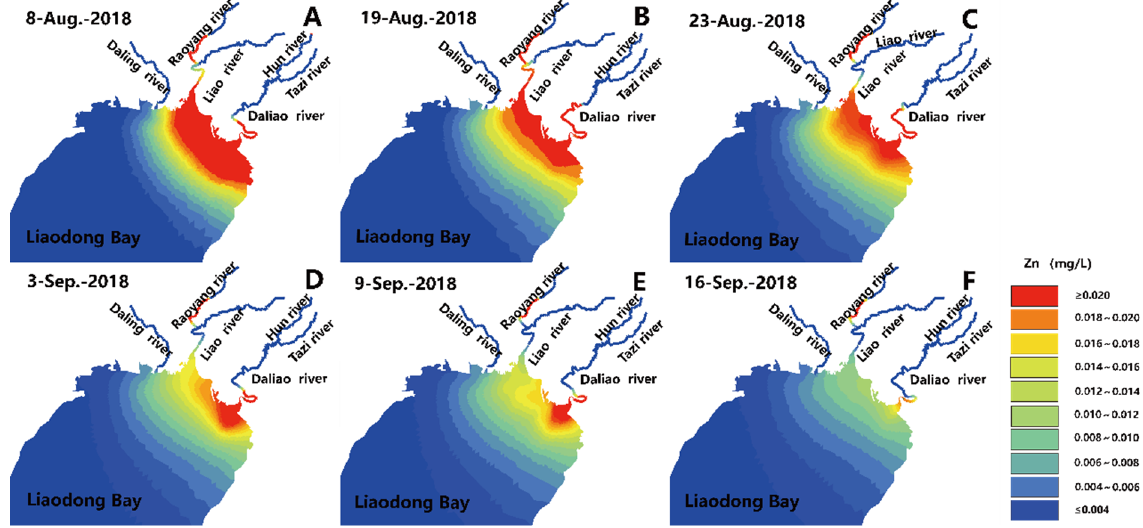
Figure 10. Hun River outbreak of water pollution accident pollutant transport spread.